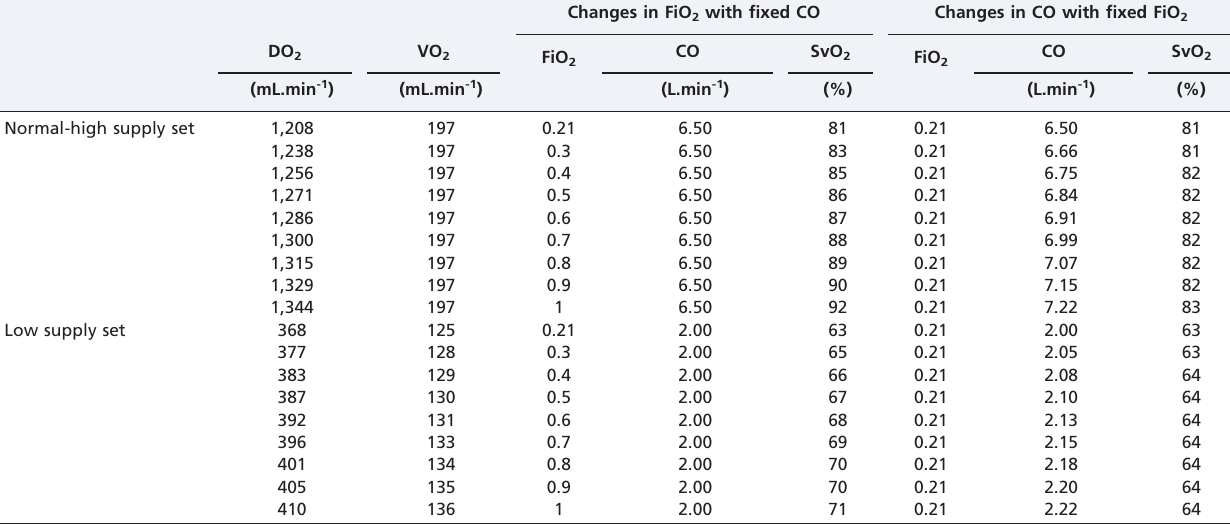
Table 1 - Effect of increasing the oxygen delivery on oxygen venous saturation by manipulating either the inspired fraction of oxygen or the cardiac output.